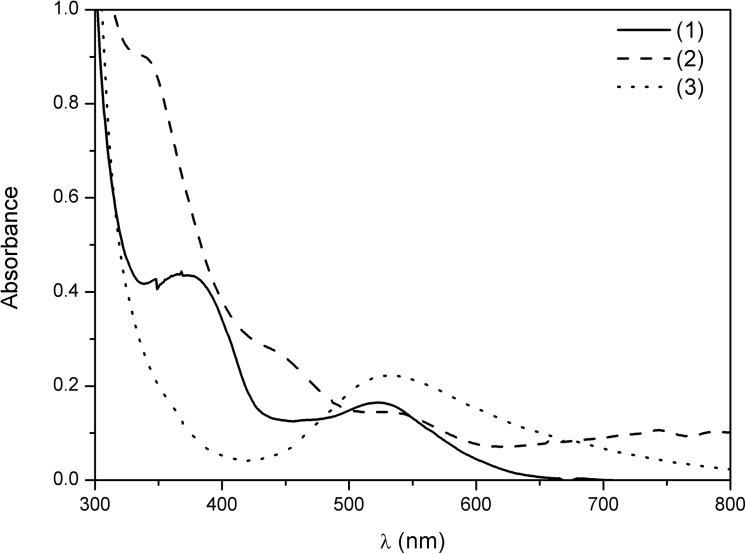
Electronic spectra of the complexes (1), (2), and (3) in water.[Co(L)(H2O)](ClO4)2 (1) and [Cu(HL)](ClO4)2 (3) at 3×10−3 mol dm-3, [Ni(HL)](ClO4)2 (2) at 3×10−2 mol dm-3.